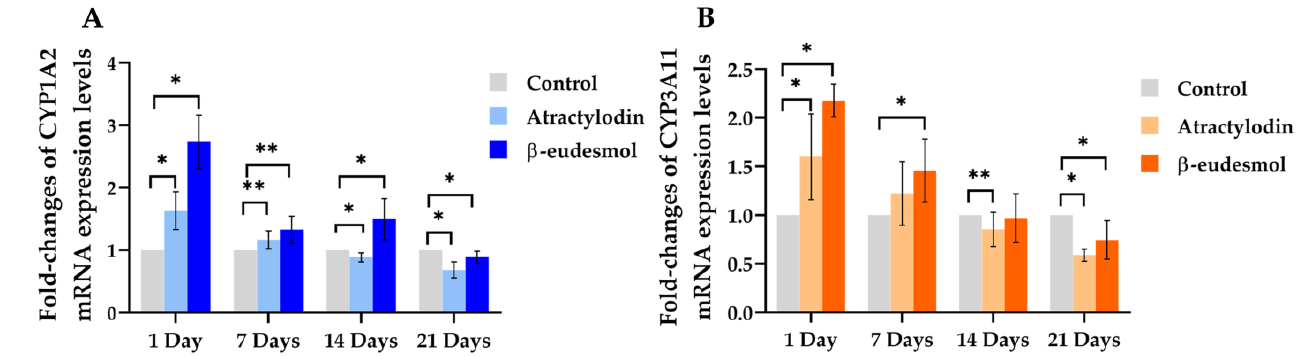
Figure 1. Fold-changes of mCYP1A2 and mCYP3A11 mRNA expression levels in mouse livers. The mRNA expressions of mCYP1A2 ( A ) and mCYP3A11 ( B ) in mouse livers were investigated in male ICR mice following a daily oral dose of 100 mg/kg body weight of atractylodin or β -eudesmol for 1, 7, 14, and 21 days. Control mice were fed with distilled water. Data are expressed as median (95% CI) from three experiments (duplicate each). Asterisks indicate significant differences from the control. Statistical significance with * p = 0.002, ** p = 0.04 compared with control.